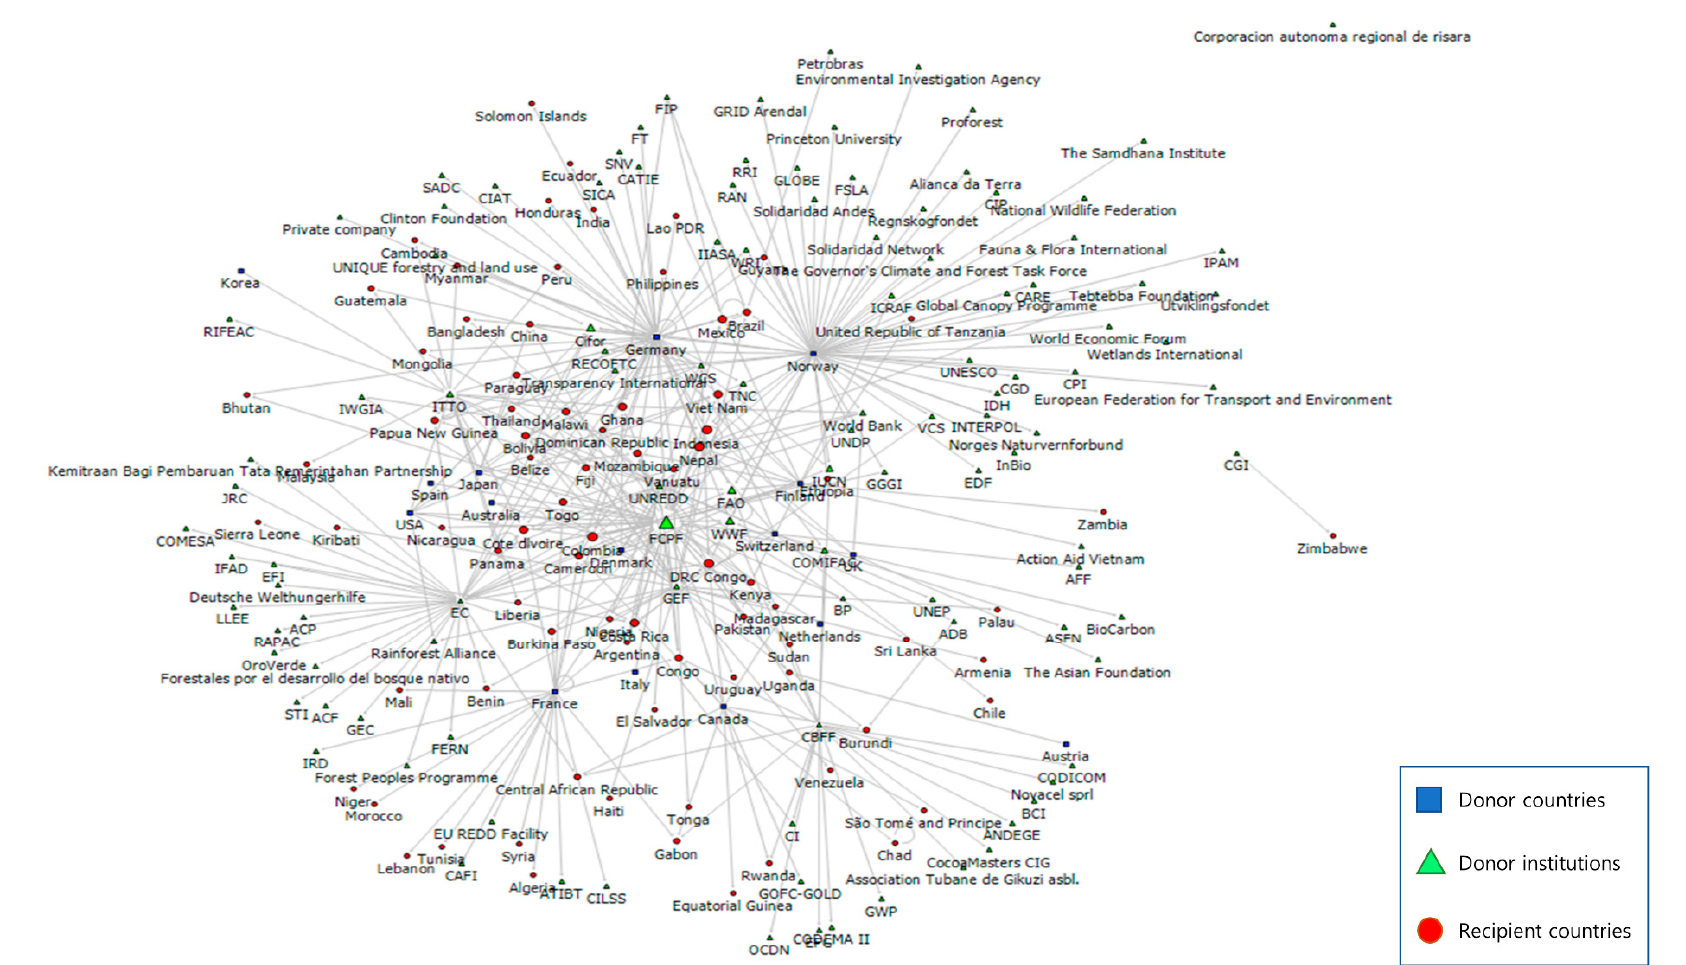
Figure 6. In-degree centrality in global REDD+ financial network in 2015.